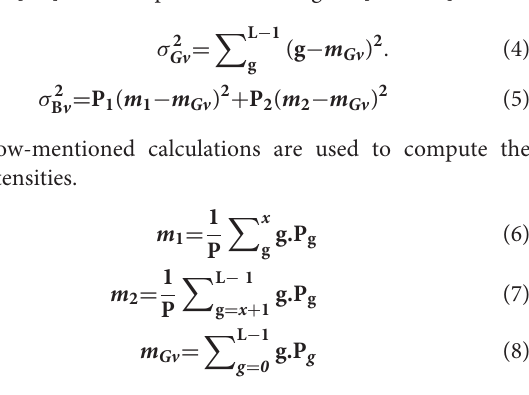
Algorithm 1 | Cuckoo search